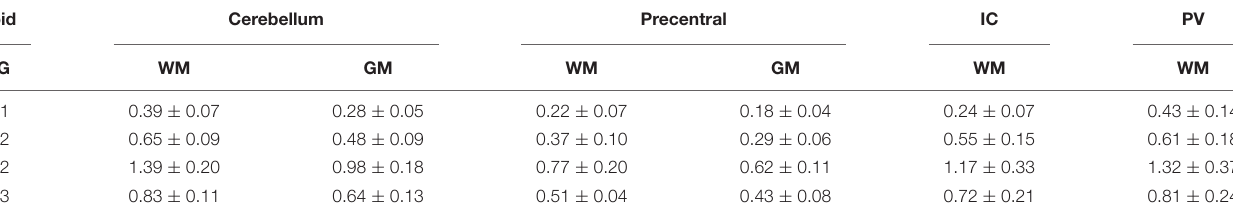
TABLE 2 | Levels of triacylglycerol (TAG) in regions of the formalin fixed human brain ( n = 21): cortical gray matter (GM) of the cerebellum, white matter (WM) of the superior cerebellar peduncle, cortical gray and subcortical white matter of the precentral gyrus, internal capsule (IC) and periventricular (PV) white matter. Lipid